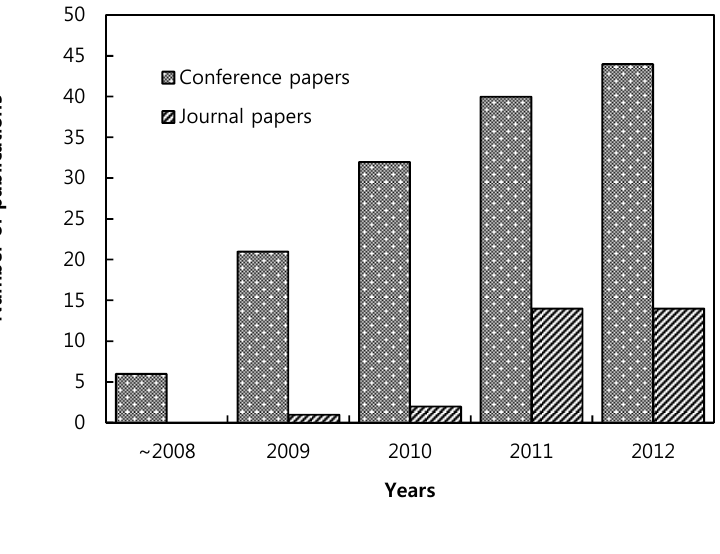
Figure 7. Number of research papers related to WSCRNs published in IEEE